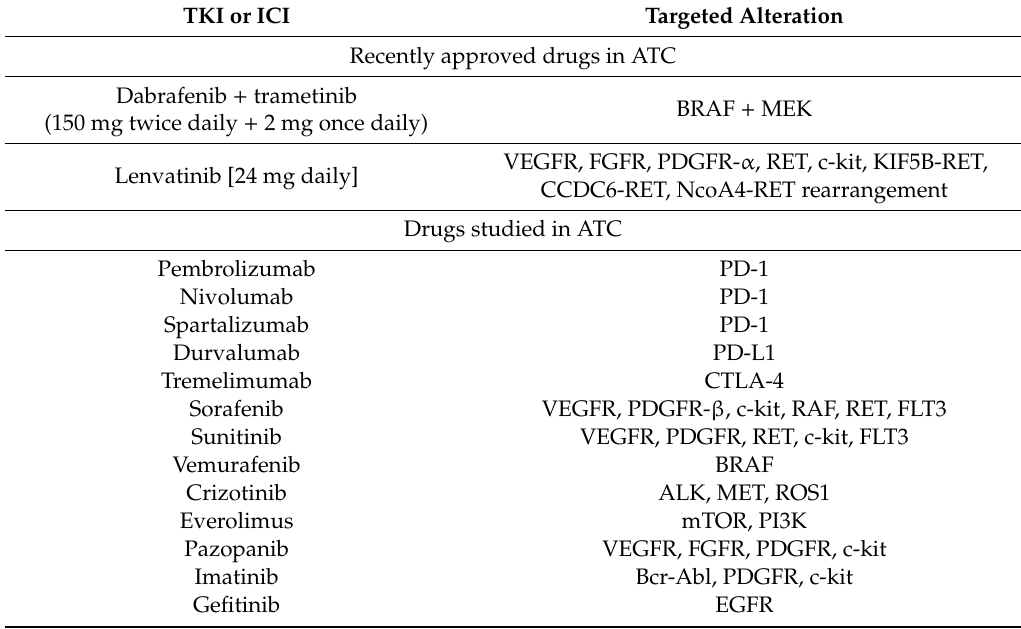
Table 3. Tyrosine kinase and immune checkpoint inhibitors studied in ATC. TKI or ICI Targeted Alteration Recently approved drugs in